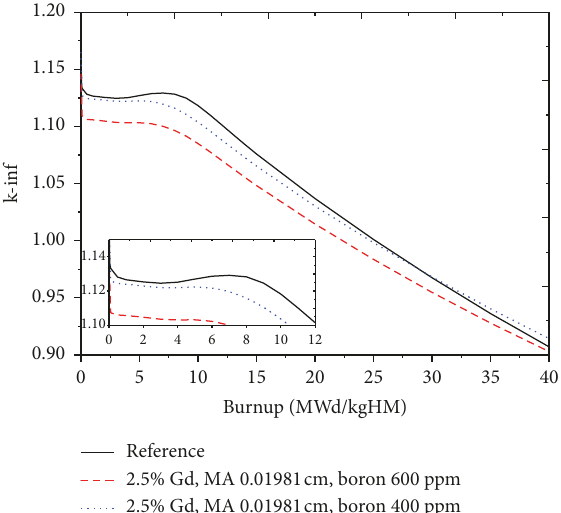
Figure 20: The k-inf versus burnup when coating a thin layer of MAs to the UGD pins and reducing GD to 2.5wt.%.